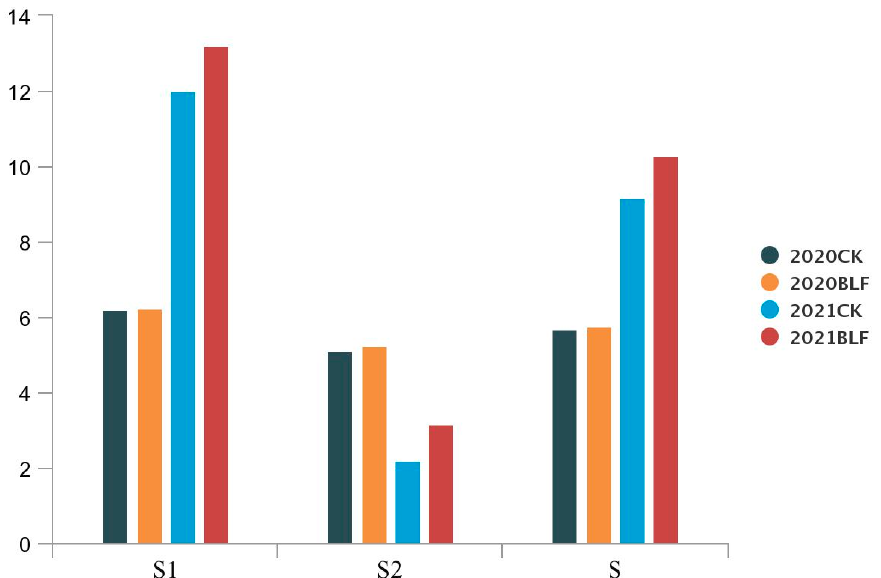
Figure 5. Principal components for anthocyanins in ‘Cabernet sauvignon’ grape skins from BLF and CK treatments in 2020 and 2021. S1, Score of component 1; S2, Score of component 2; S, Synthetic score. Table 5. Relative concentrations of volatile compounds in ‘Cabernet sauvignon’ grapes from BLF and CK treatments in